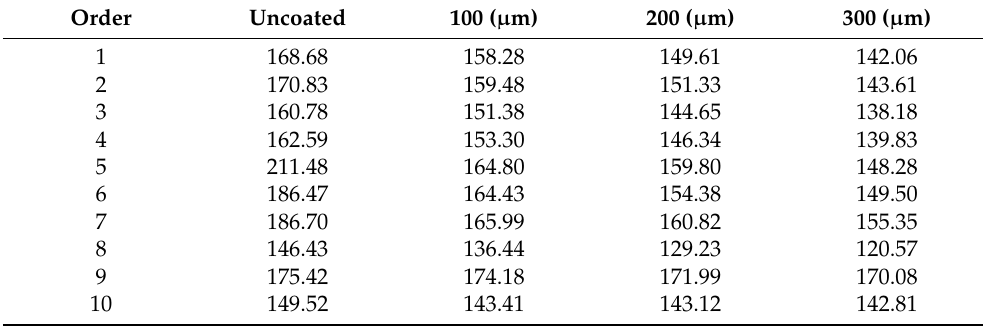
Figure 6. Maximum deformation of the main vibration mode of the TA18 titanium alloy straight aviation hydraulic pipe coated with different thicknesses: ( a ) with the YSZ coating; ( b ) with the YSZ–PTFE coating. Table 6. Natural frequency (Hz) of the TA18 titanium alloy straight aviation hydraulic pipe coated with the YSZ–PTFE coating at different coating thicknesses.